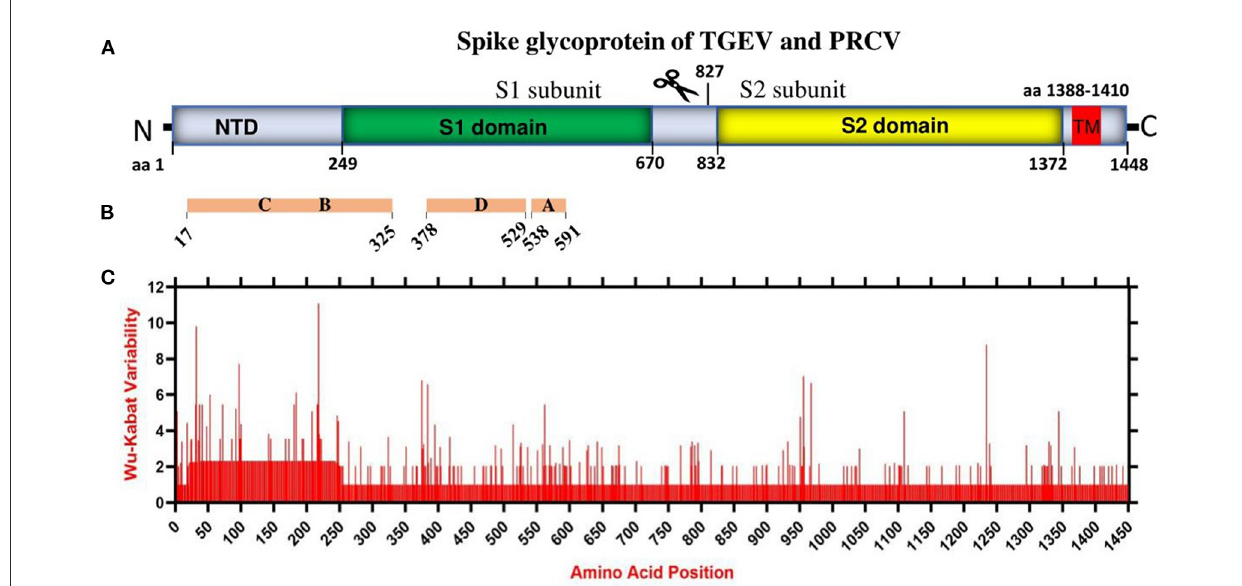
FIGURE2 The amino acid variation landscape of TGEV and PRCV spike glycoprotein. (A) Domain structure of TGEV S glycoprotein, including NTD (aa 1–248), S1 domain (aa 249–670), S2 domain (aa 832–1,372), TM (aa 1,388–1,410) and C-terminal cytoplasmic tail (aa 1,411–1,448). (B) The brown blocks represent the relative positions of known sites containing neutralizing epitopes in the spike glycoprotein of TGEV (17). (C) Amino acid variation landscape. The amino acid sequences of all available complete spike proteins (a total of 58, Supplementary Table 1) of TGEV and PRCV were separately retrieved from the NCBI database and were aligned with ClustalW using the MEGA11 software (37). The protein variability was determined using the Wu-Kabat variability coefficient offered by the Protein Variability Server (PVS) (39). The Wu-Kabat variability coefficient describes the susceptibility of an amino acid position to evolutionary replacements and is computed using the following formula: variability coefficient = N*k/n, where N is the number of sequences in the alignment, k is the number of different amino acids at a given position and n is the frequency of the most common amino acid at that position. Y-axes represent the Wu-Kabat variability coefficient values, where the estimation limit is set as “1”. Above the limit of “ > 1” represents variations. X-axes represent the amino acid